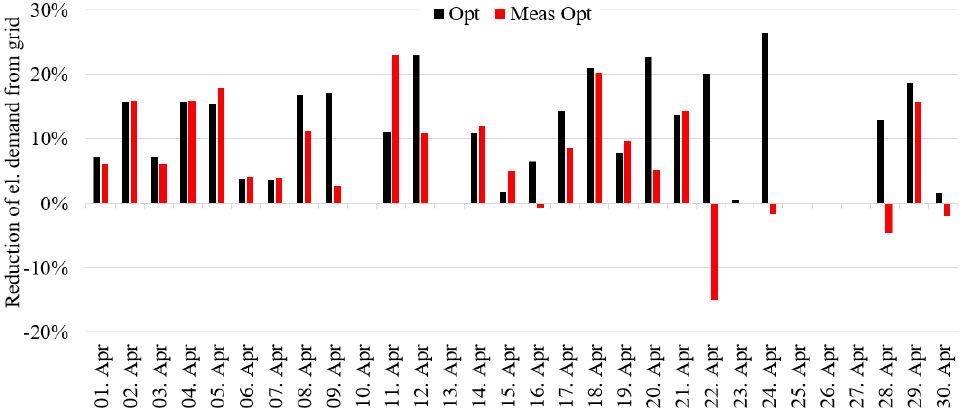
Figure 7. Daily optimization results for a single building for the month